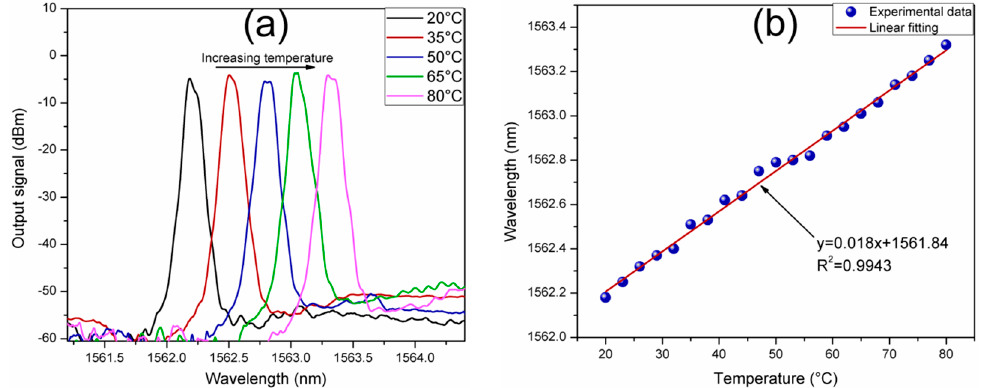
Figure 8. ( a ) The output signal of the laser sensor under temperature variations; ( b ) Laser peak wavelength as a function of the surrounding temperature.